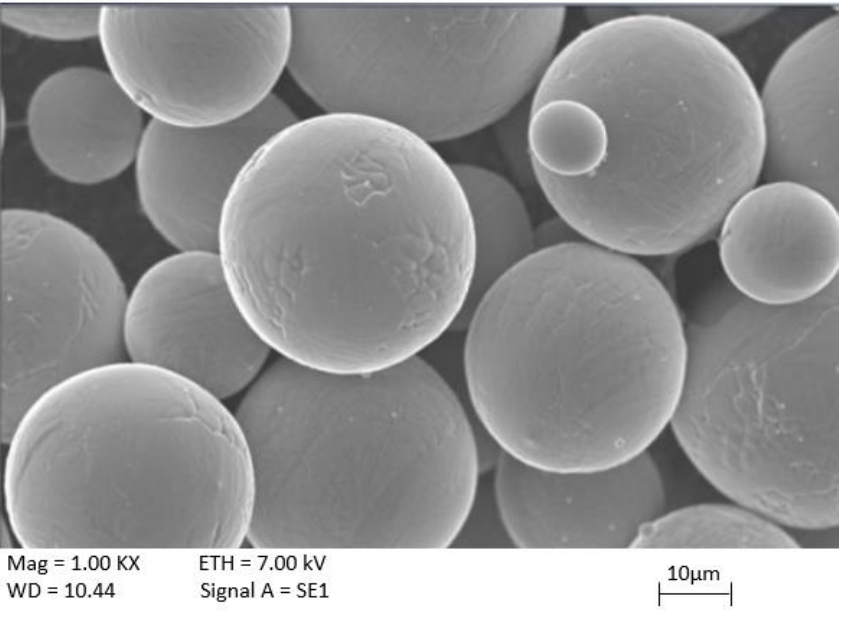
Figure 1. Scanning electron microscope (SEM) image of CP Ti Grade II powder morphology .